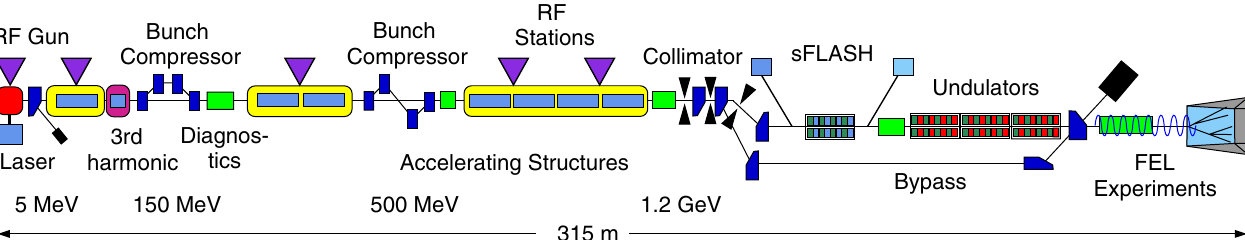
FIG. 12. FLASH layout [40]. The laser lab and the experimental hutch are shown as blue squares.